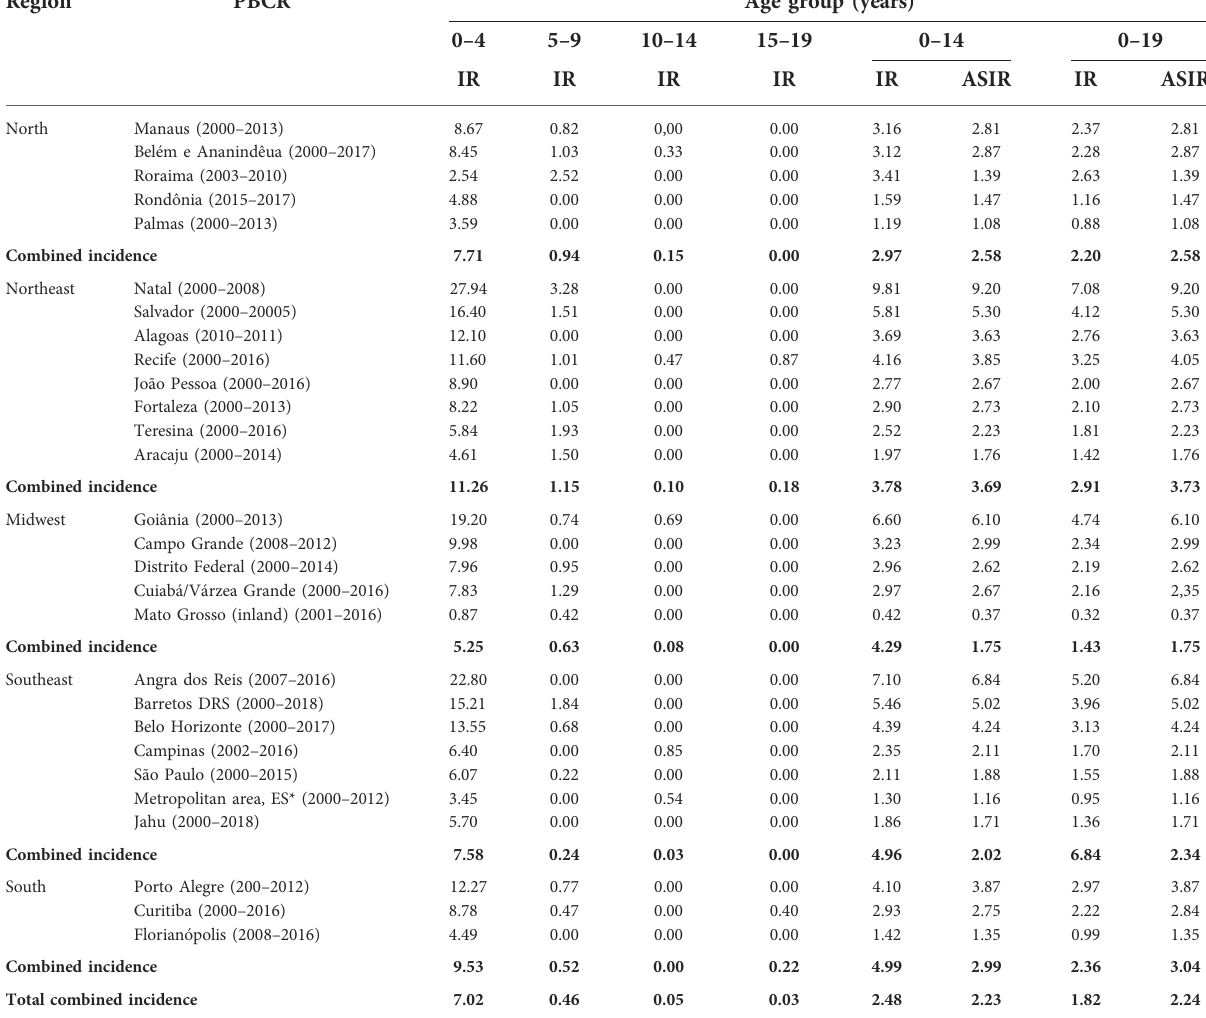
TABLE 3 Crude and adjusted incidence rates of retinoblastoma per 1 million children and adolescents aged 0 to 19 years, by local Population-Based Cancer Register (PBCR) and respective reference periods, National Cancer Institute, Ministry of Health, Brazil. Region